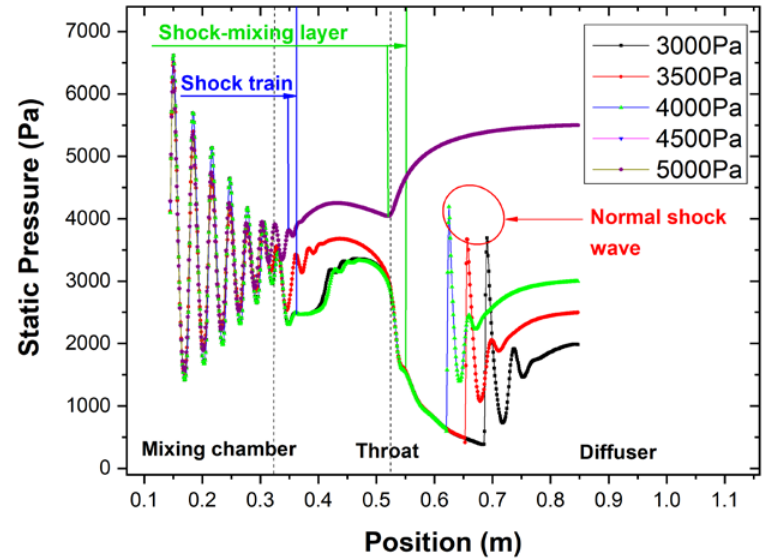
Figure 16. Comparison of static pressure distribution along the ejector axis by different back pressure.